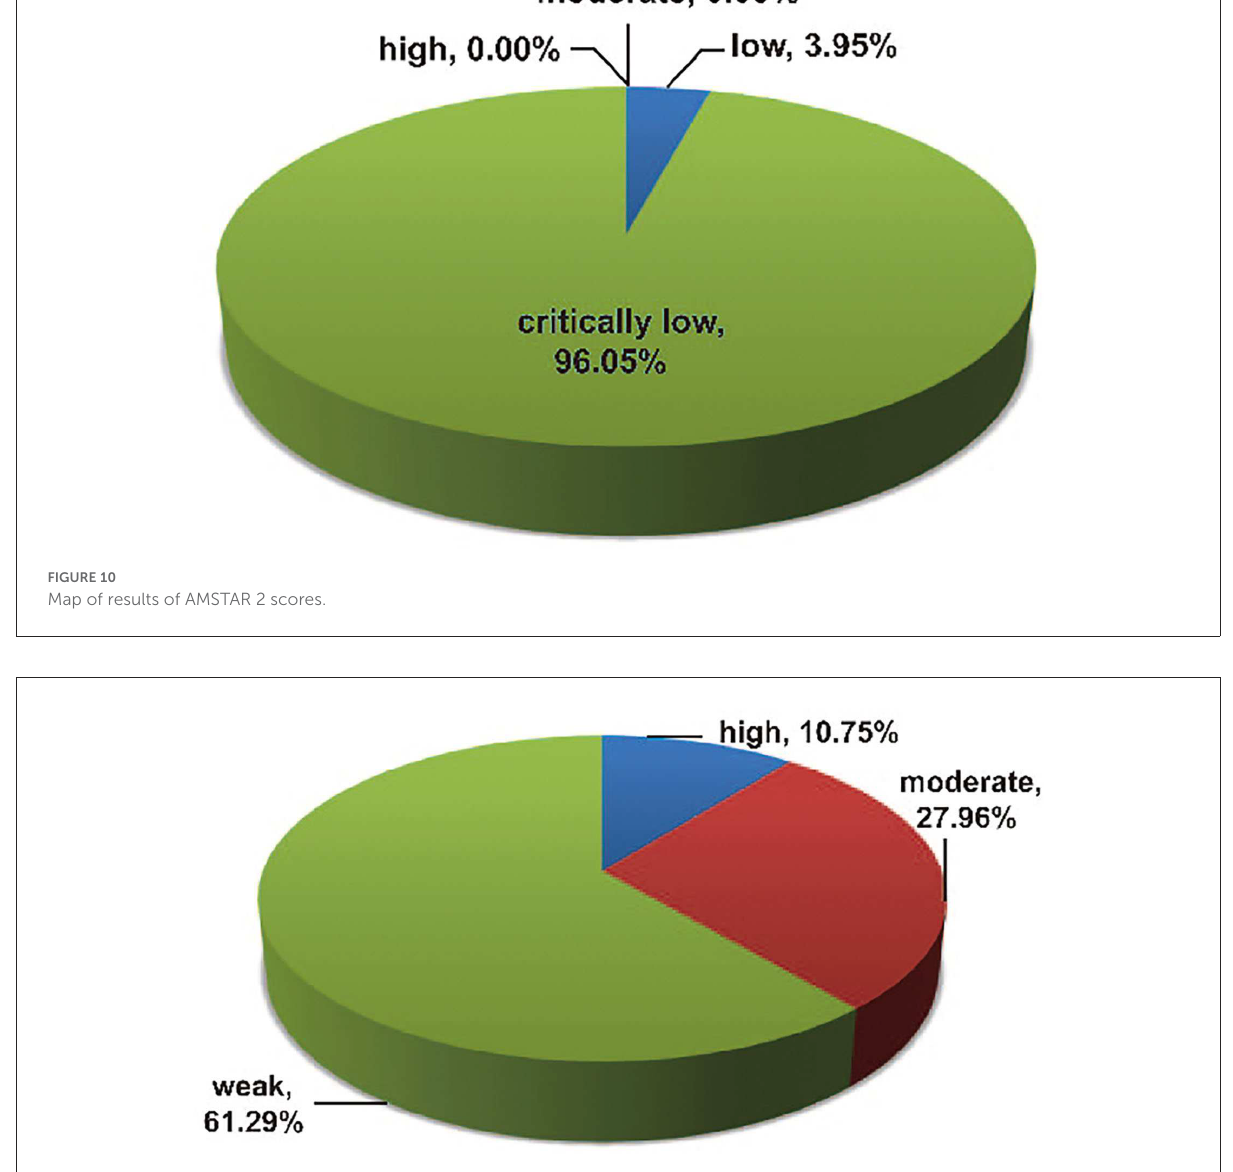
FIGURE11 Map of results of epidemiologic evidence